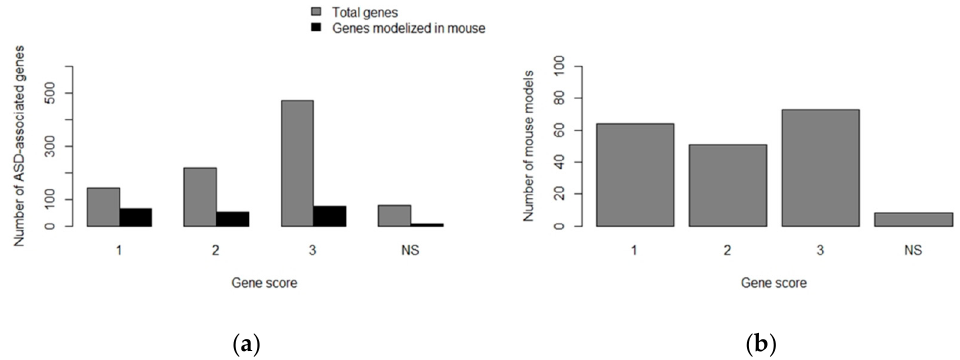
Figure 4. Mus musculus models developed to study ASD-associated genes. ( a ) Comparison between the human ASD-associated genes deposited in the SFARI Gene Database, and the number of ASD-associated genes modeled in Mus musculus . Genes are classified according to their SFARI gene score (NS = non-specified); ( b ) Number of mouse models developed to study ASD-associated genes, classified according to the SFARI gene score (NS = non-specified). The figure was elaborated using open-access data from SFARI Gene Database (obtained in January 2020) and R software [6,20,21].